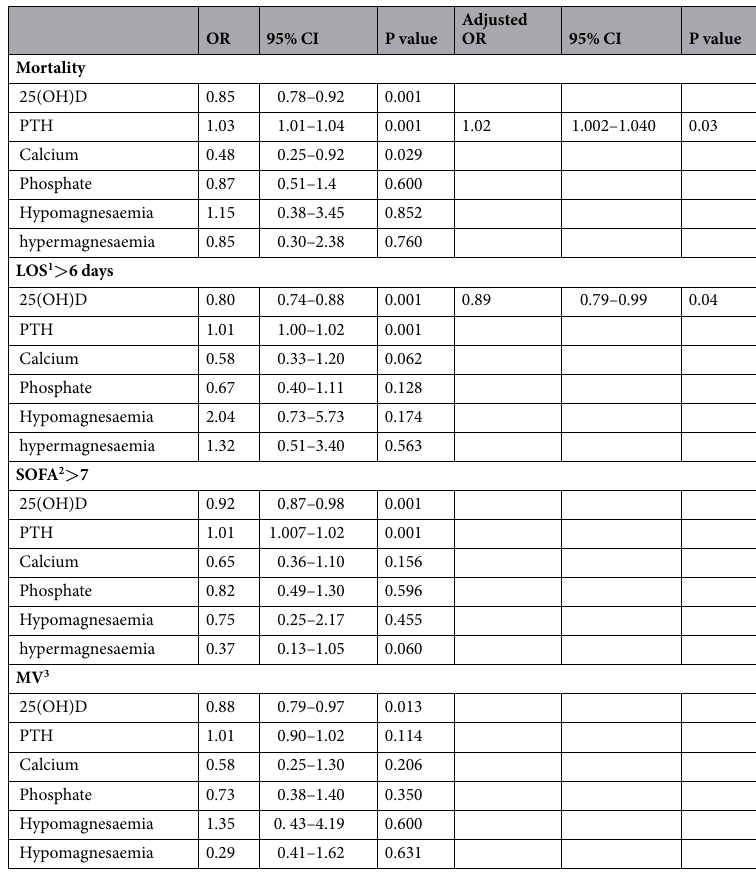
Table 2. Logistic regression for clinical outcomes in 210 patients according to serum 25(OH)D and parathormone level. 1 Length of stay; 2 Sequential Organ Failure Assessment Score; 3 Duration of mechanical